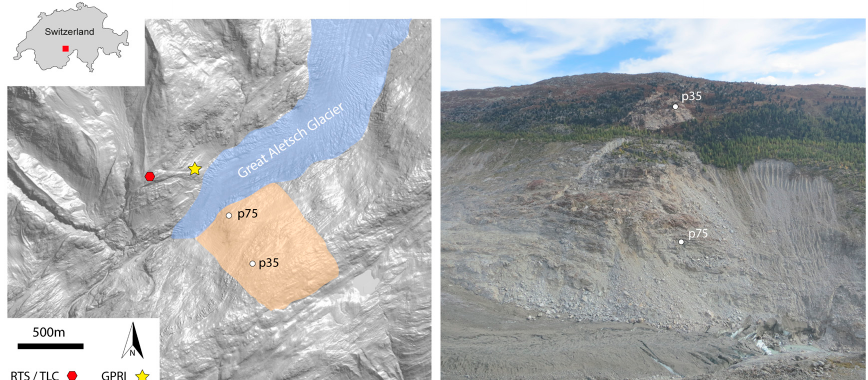
Figure 1. Geographic overview of the area of study, i.e., the Moosfluh rock slope instability located in the vicinity of the Great Aletsch Glacier, Swiss Alps. ( Left ) Moosfluh rock slope instability (orange shading) and Great (blue shading) on the hill shade model. The position of ground based monitoring instruments is also indicated, i.e., Robotized Total Station (RTS), Time Lapse Camera (TLC), and GAMMA Ground Portable Radar Interferometer (GPRI). ( Right ) Picture of the Moosfluh instability acquired on 28 September 2017 during the GPRI survey. The two points, p35 and p75, are reflectors (prisms) monitored hourly from the RTS. See text for more